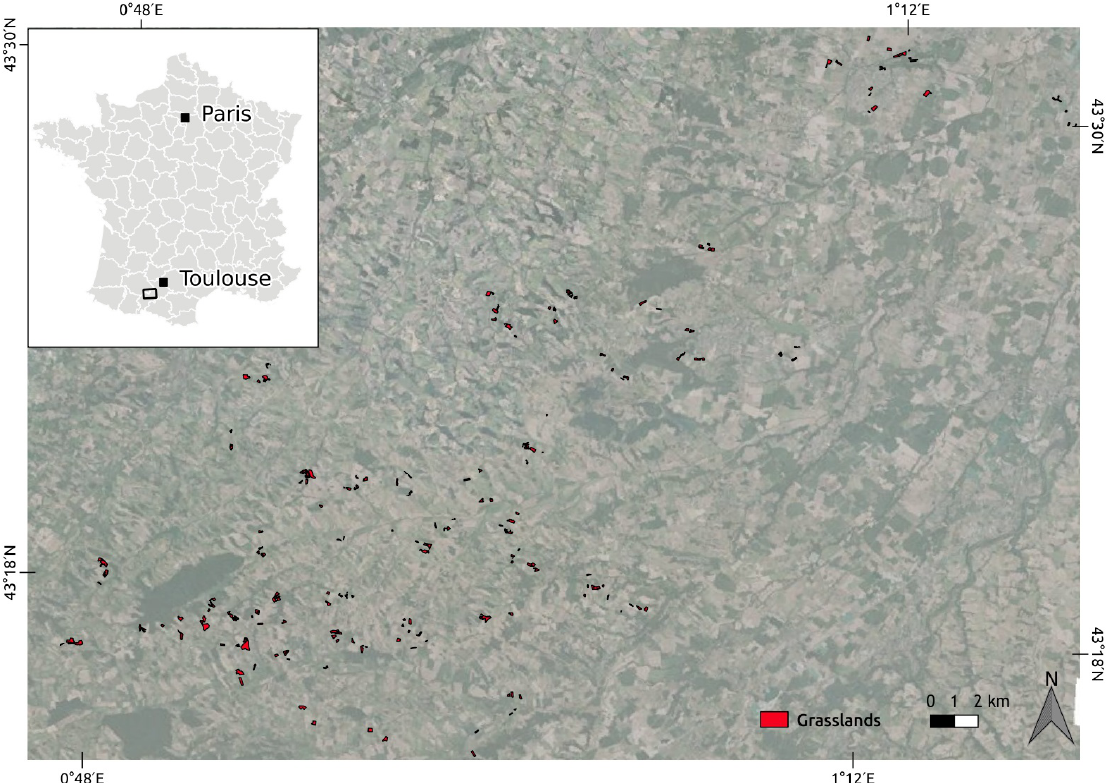
Figure 1. Location of the study area in southwest France and of the grasslands within the study area. The background is an aerial photograph issued from the French orthophoto database “BD ORTHO R (cid:13) ” ( c (cid:13) IGN).